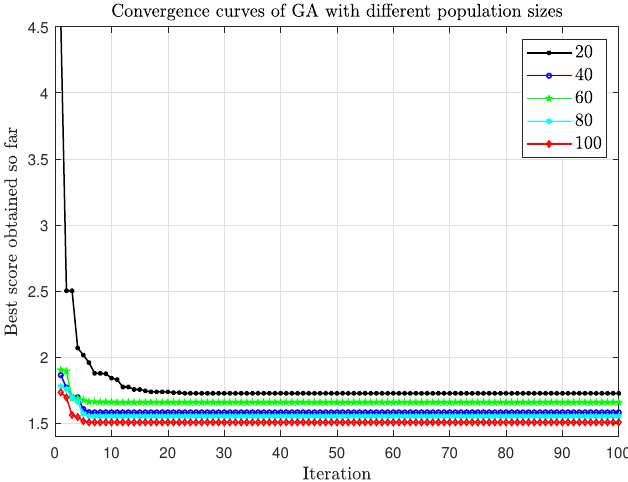
Figure 3. Convergence curves of GA with various population sizes.